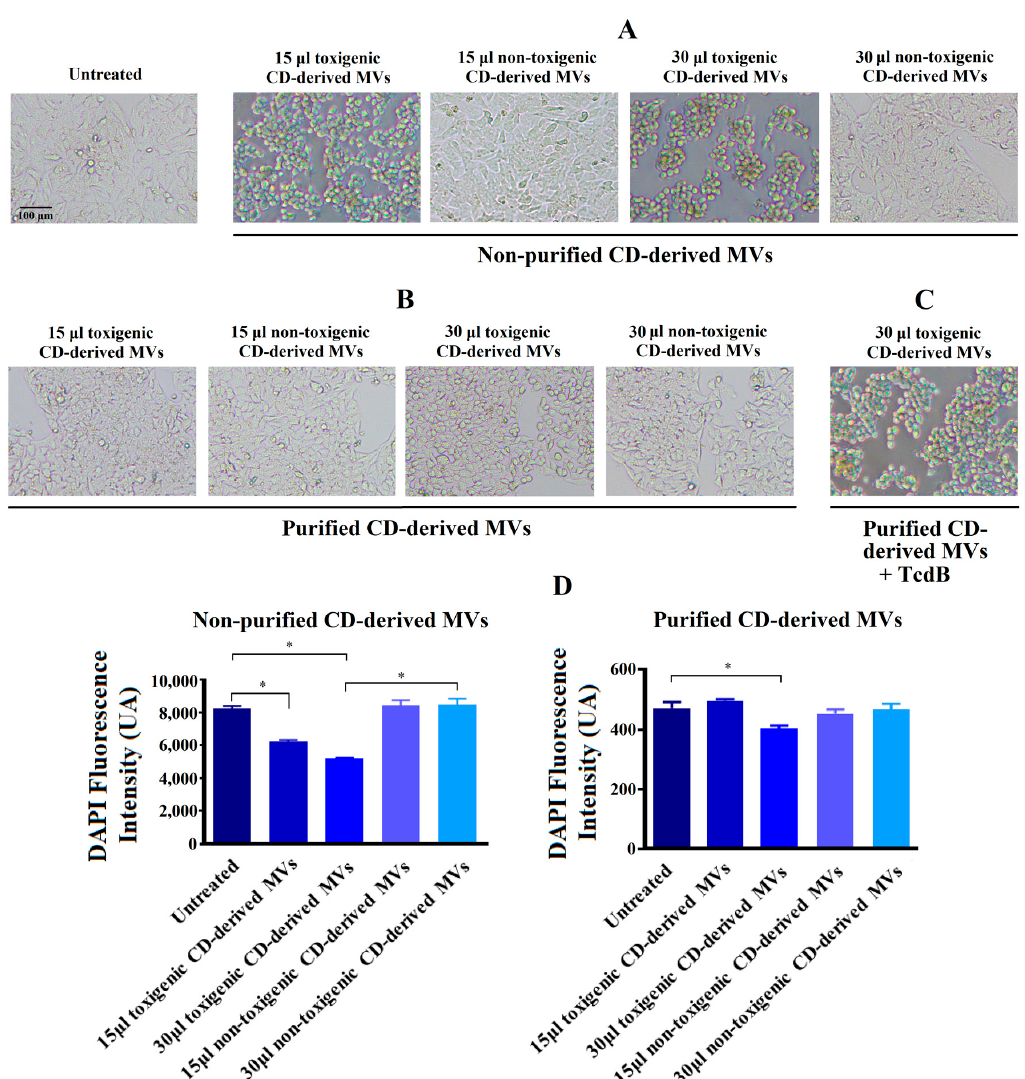
Figure 4. Changes produced by C. difficile (CD)-derived MVs on the HepG2 cells’ morphology and quantification of fixed adherent cells by the DAPI staining. HepG2 cells were treated with 15 and 30 μ g/mL of non-toxigenic and toxigenic C. difficile -derived MVs during 24 h. ( A ) Effect of non-purified C. difficile -derived MVs. ( B ) Effect of purified C. difficile -derived MVs. ( C ) HepG2 cells treated with purified and toxigenic C. difficile -derived MVs and TcdB (3 ng/mL). ( D ) Quantification of adherent cells measured by changes in DAPI fluorescence intensity in HepG2 cells after MVs incubation. Data represent mean ± SEM ( n = 3). * p < 0.05.